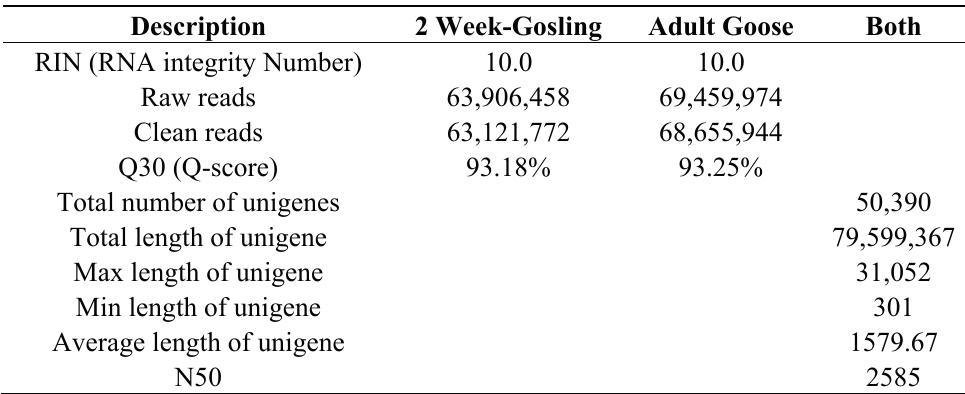
Figure 1. Histological changes in goose spleens at different developmental stages. The spleen samples from the gosling ( A – C ), and the adult goose ( D – F ) were cut into sections and stained with hematoxylin and eosin (H&E). The parenchyma in the gosling spleen was sparse. However, well-developed spleen parenchyma was detected in the adult goose. G indicates germinal centers; P indicates periarteriolar lymphoid sheaths; arrows indicate lymphocytes. Table 1. Summary for goose spleen